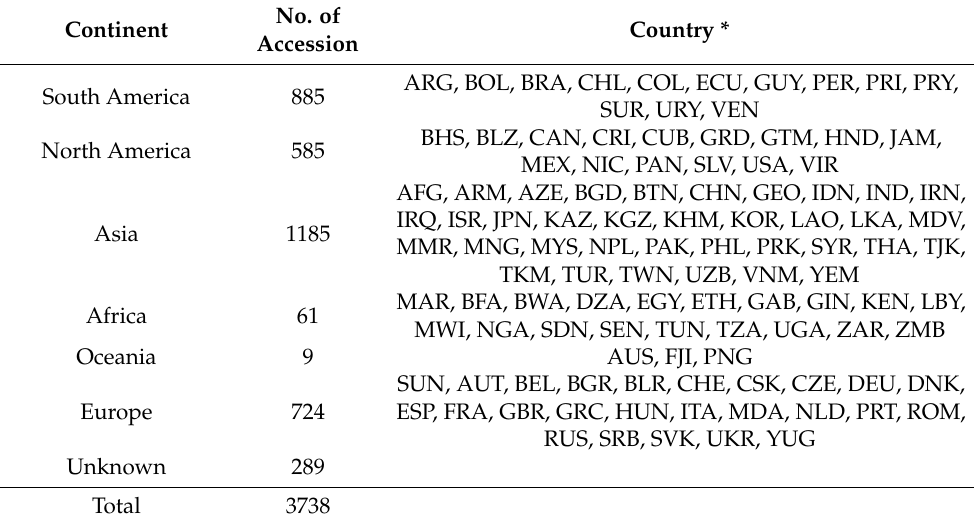
Table 1. Origin distribution of Capsicum genetic resources for evaluation of resistance against anthracnose disease in this study. No. Continent